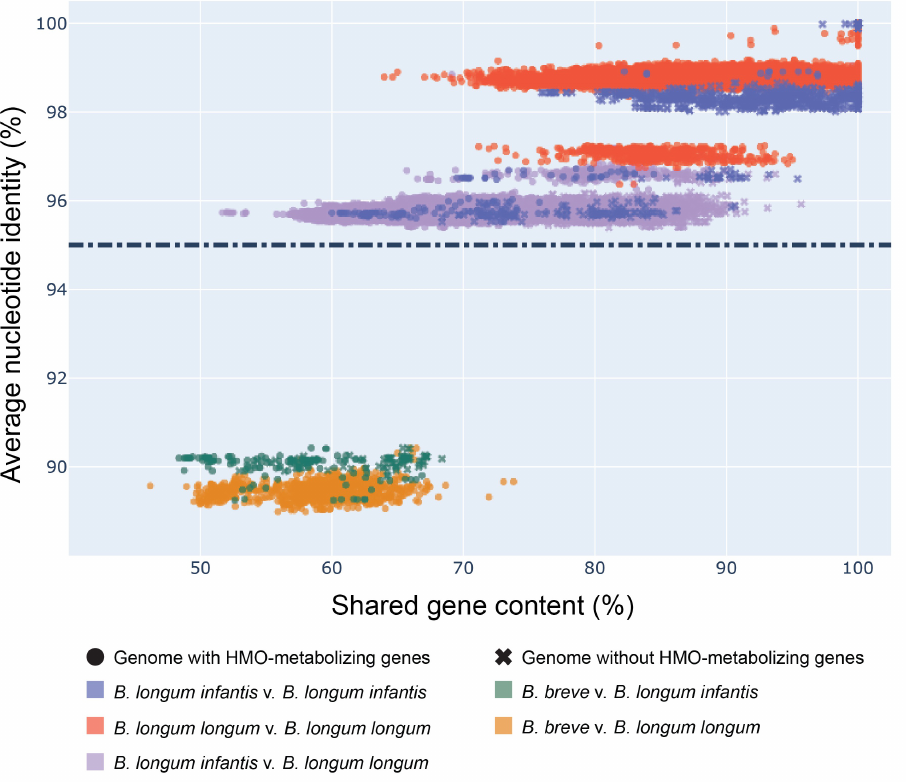
Figure 1. B. infantis genomes cluster separately from B.longum . Scatter plot of percent shared gene content versus ANI values across pairwise comparisons of Bifidobacterium genomes. Shared gene content calculated from BLAST and ANI values calculated by the Python package pyani. Presence of HMO-metabolizing genes determined by the occurrence of at least 60 of 79 (75%) genes in a genome. Dashed line indicates the ANI cutoff score of 95% for genomes belonging to the same